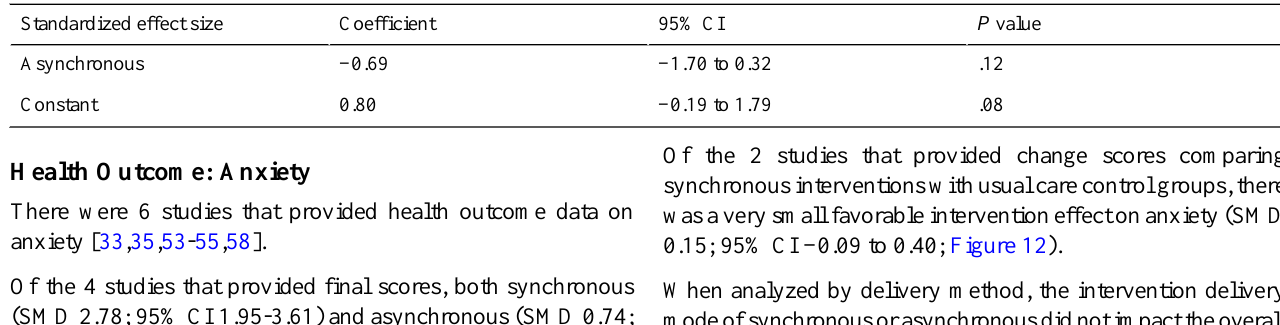
Table 7. Metaregression of synchronous and asynchronous interventions on depression outcome, analyzed using standardized effect